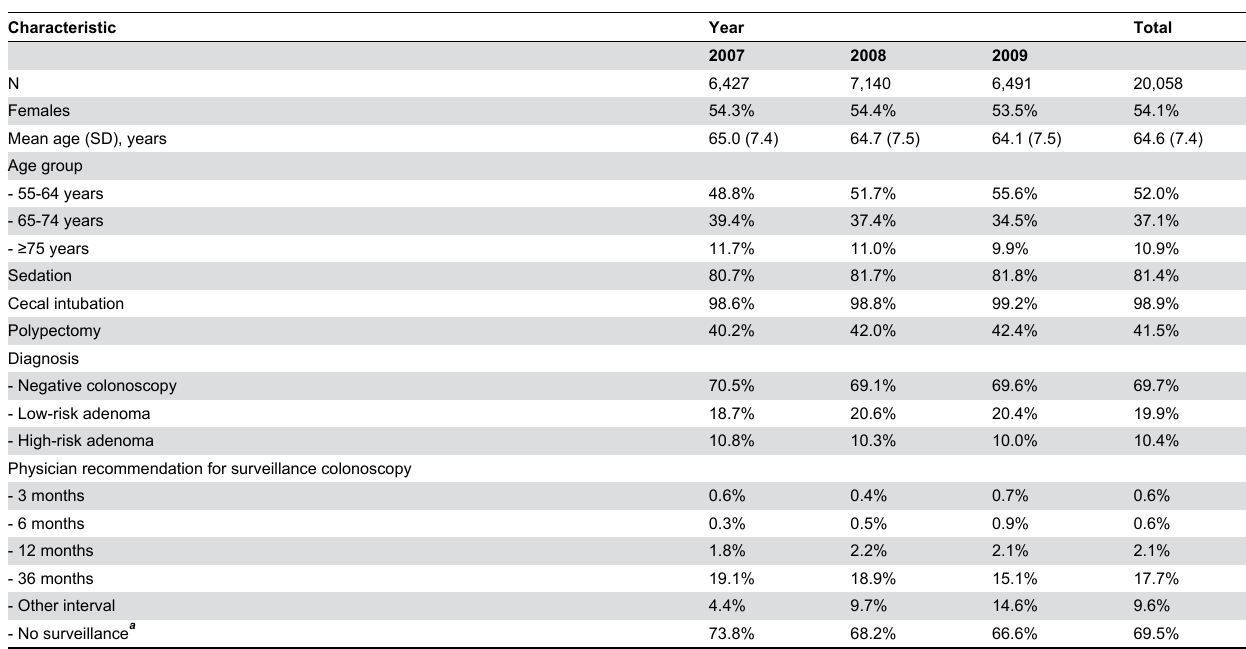
Table 1. Study population.